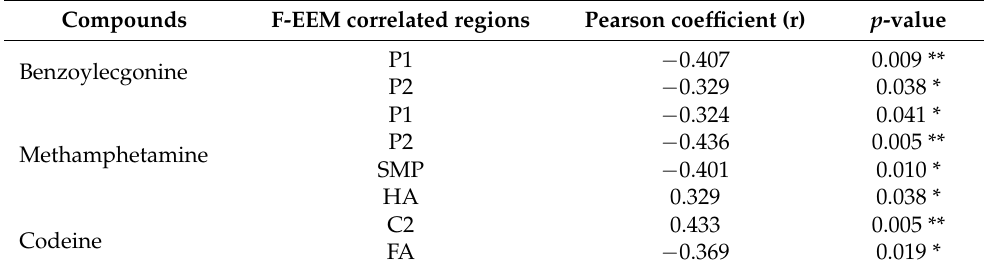
Table 3. Summary of the Pearson correlation analysis between drug removal and F-EEM